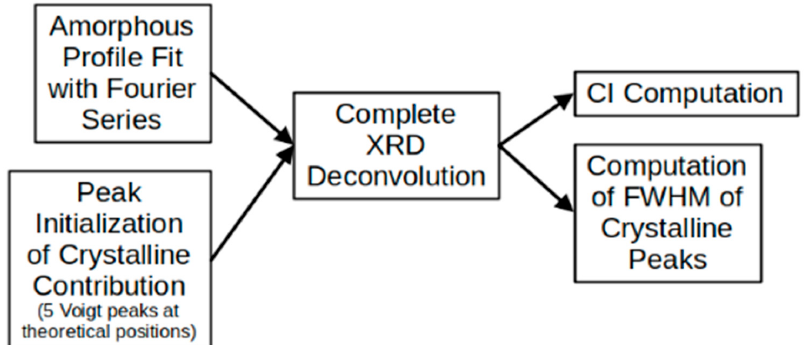
Figure 2. Diagram of main steps followed in the MATLAB routine to perform deconvolution of complete XRD profile and to obtain CI and FWHM (width) of crystalline peaks.